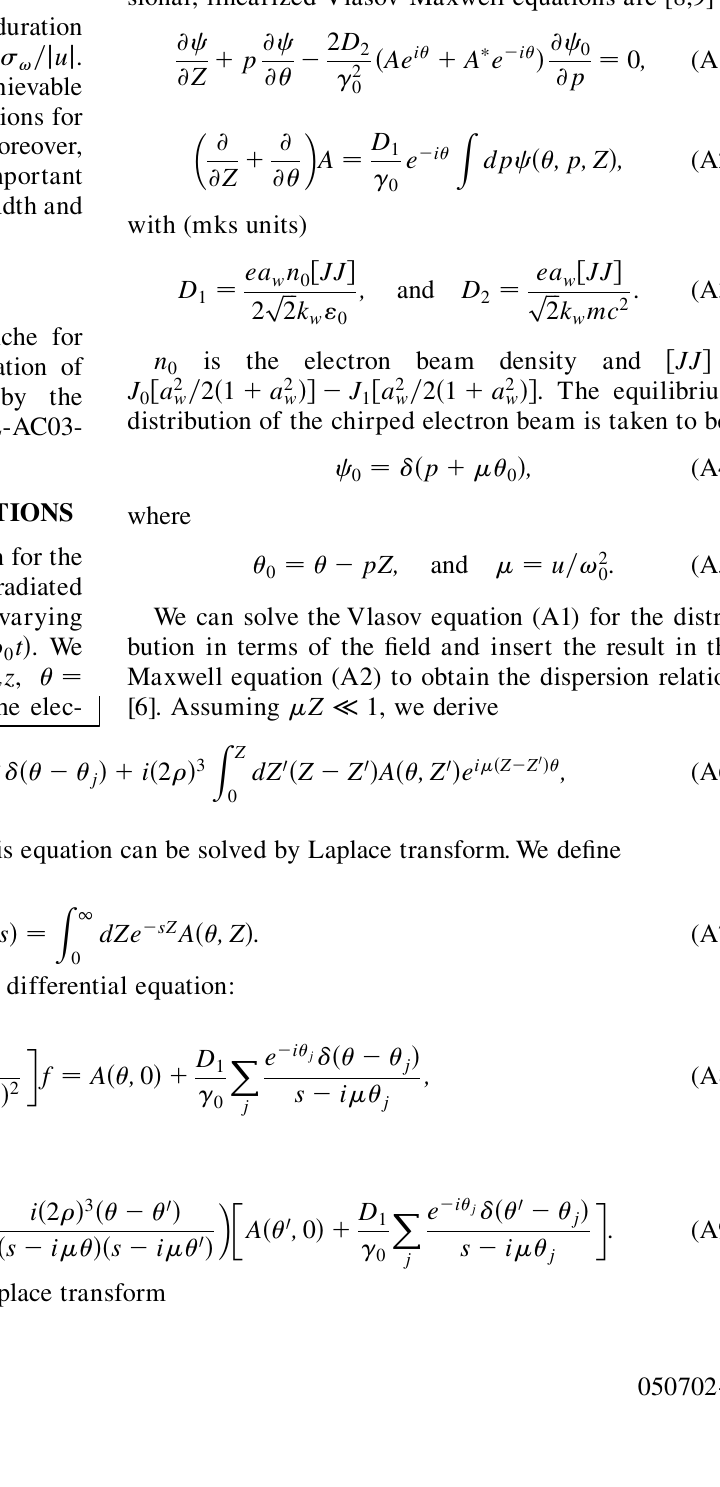
tron distribution function